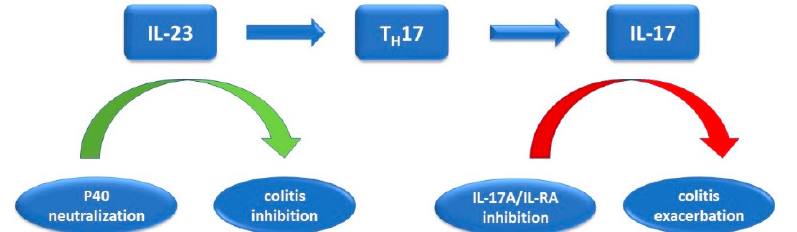
Figure 4. Effects of IL-23 and IL-17 inhibitors on colitis: IL-23 leads to Th17 synthesis, which in turn stimulates the release of IL-17; inhibition of IL 23 and IL-17 leads to two paradoxically different reactions.